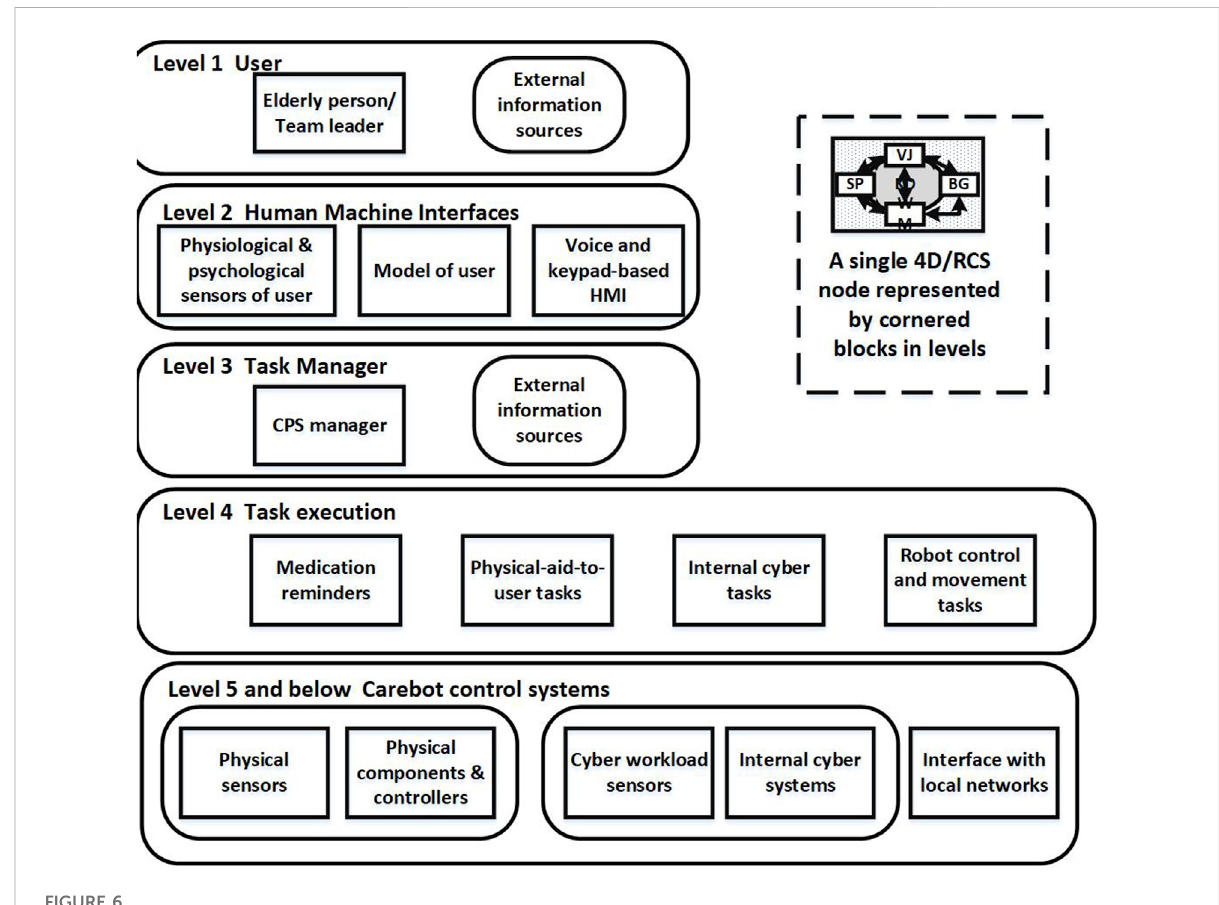
FIGURE 6 Carebot as an A-HMT-S with the elderly person as the Team